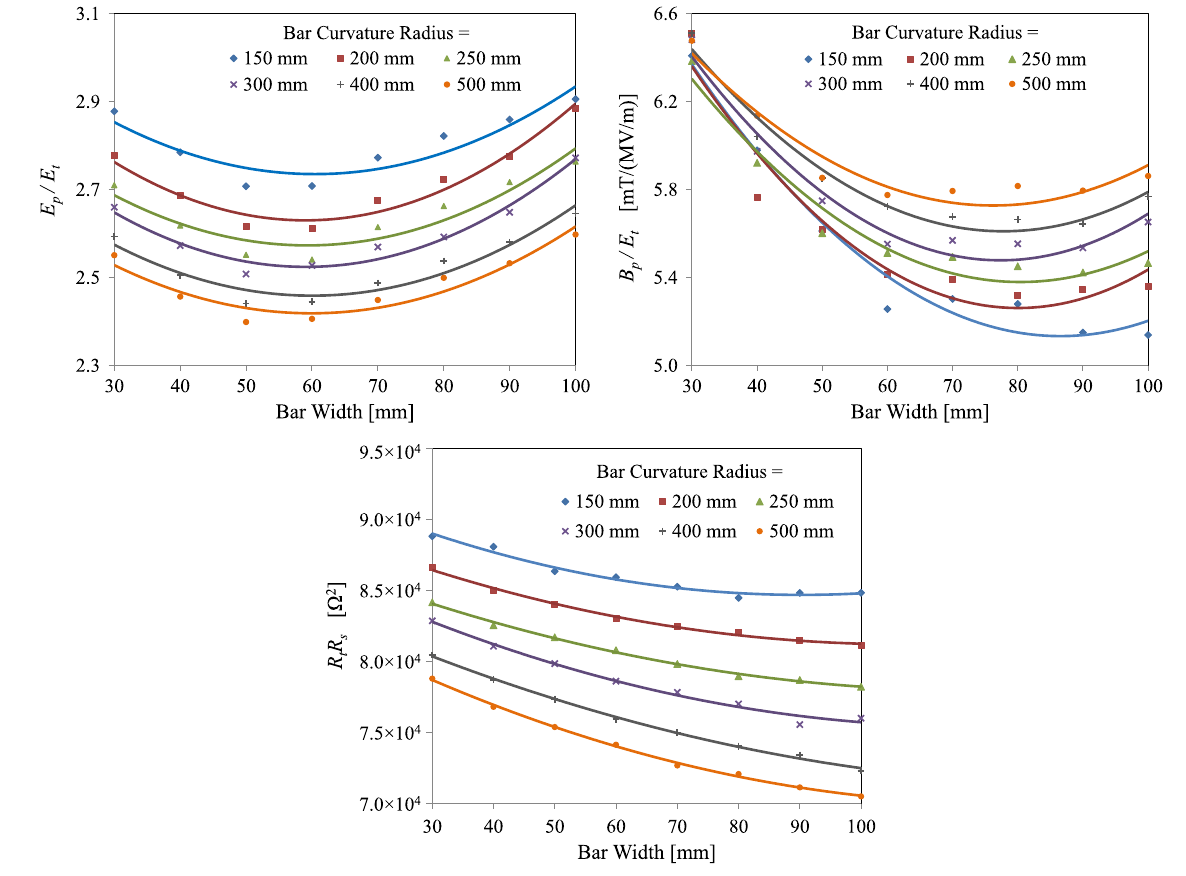
FIG. 19. Ratios of peak surface electric field ( E p ) and magnetic field ( B p ) to the transverse electric field ( E t ) and R t R s with varying bar width and radius of bar curvature for race-track-shaped parallel bars [Design (D)].